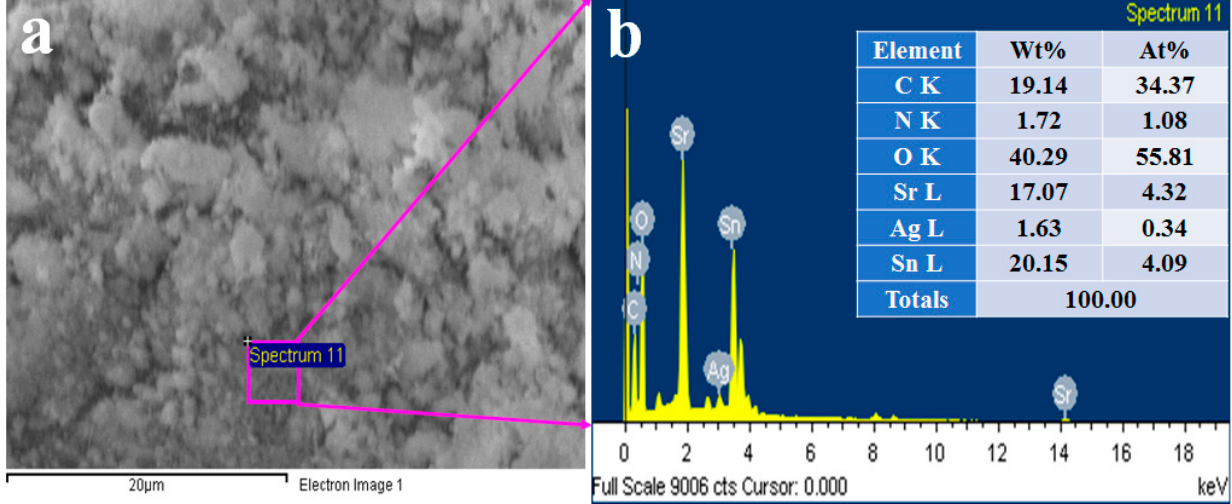
Figure 2. EDS analysis of Ag-decorated Chitosan/SrSnO 3 NC. ( a ) Higher magnifying image and ( b ) Elemental composition of synthesized Ag-decorated Chitosan/SrSnO 3 NC.